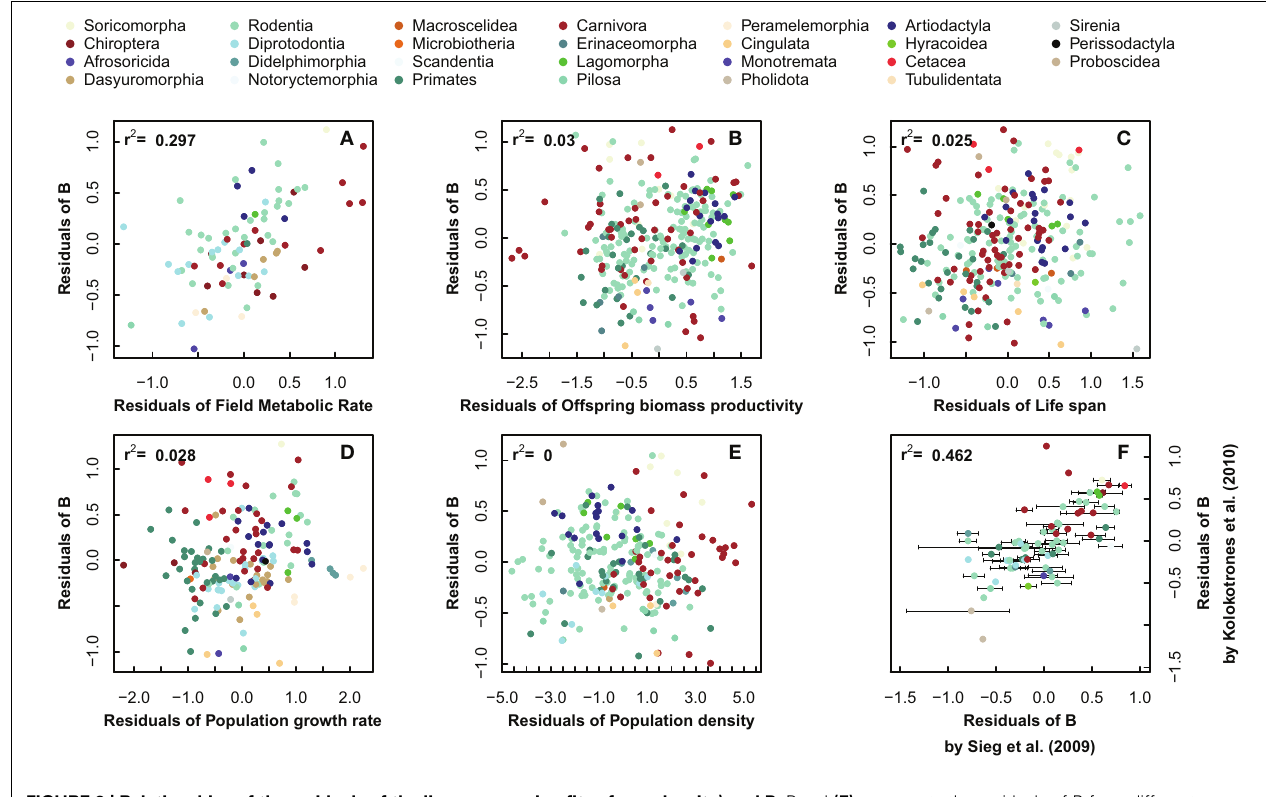
FIGURE 3 | Relationships of the residuals of the linear regression fits of each evaluated trait (A: field metabolic rate; B: offspring biomass productivity; C: life span; D: population growth rate; E: population